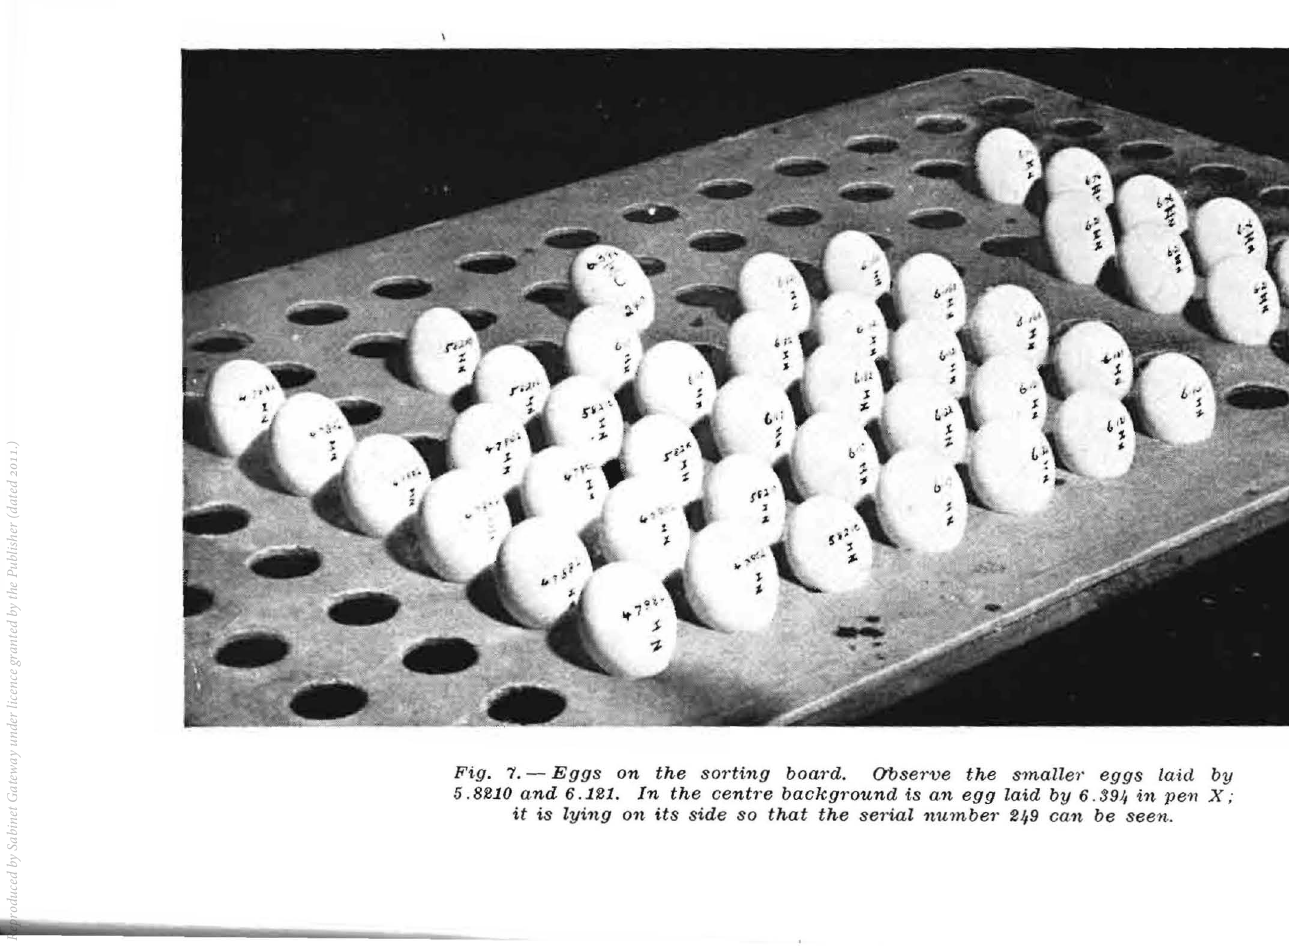
Fig. 1. - Eggs on the so,'ting bom'd. OtJsf!1've the smalle,' eggs laid by 5,8£10 and 6 ,1£1, In the cent?'e backg,'ound is an egg laid by 6,394 in pen X; it is lying on its side so tha.t the se,ial n7onbf!1' £49 can be